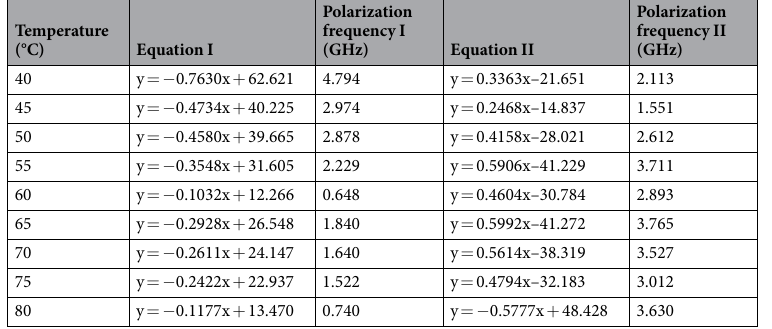
Table 1. The fitting equations of Cole-Cole curves and polarization frequency for starch–water mixtures treated using microwave heating.